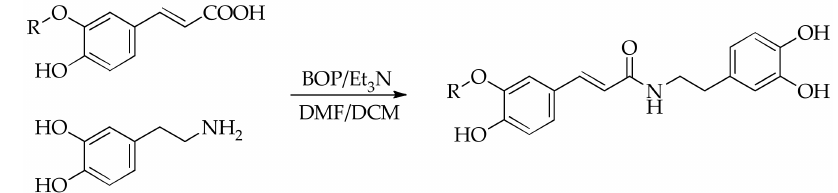
Figure 1. Synthesis of amide derivatives. R = H and CH 3 , respectively, for trans -caffeic and ferulic acid. BOP: (benzotriazol-1-yloxa)tris(dimethylamino)phosphonium hexafluorophosphate; DMF: dimethylformamide; DCM: dichloromethane; Et 3 N: triethylamine.